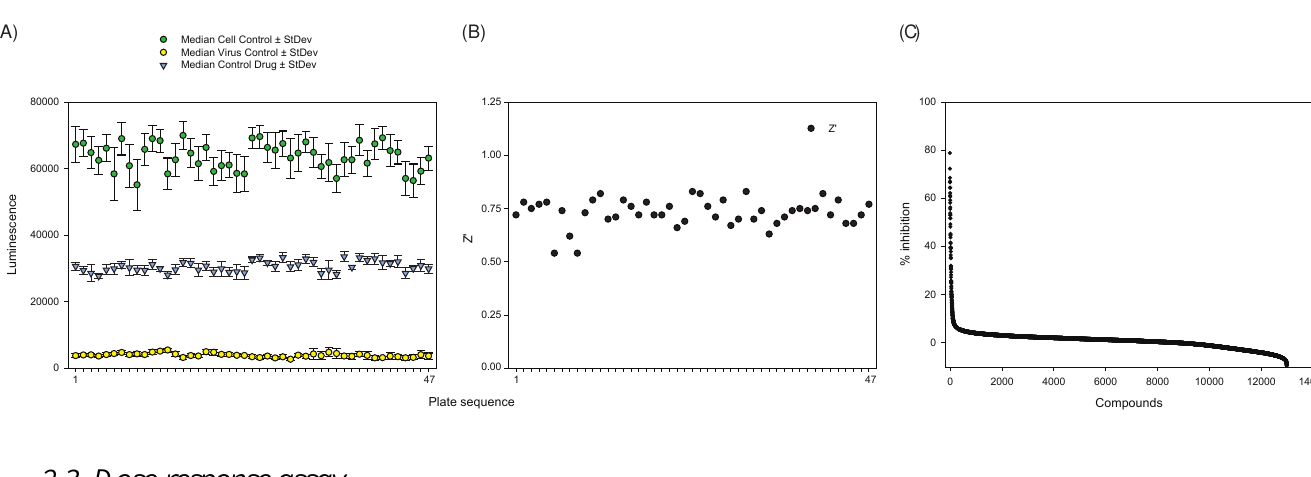
Figure 2 . Assay performance and robustness and % inhibition profiles of compounds in the primary HTS. (A) The average luminescence readings for cell control, virus control and control drug, MPA at 5 µg/mL of 47 plates depicted with standard deviations (B) Assay robustness depicted with Z ′ values with a median of 0.74. (C) Percent inhibition ranging from 79% to -10% with a mean of